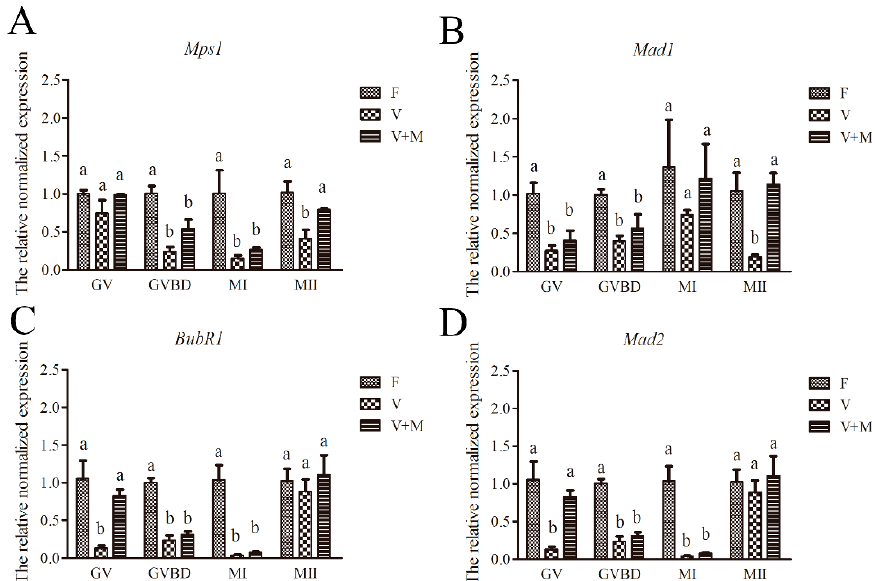
Figure 6. E ff ects of melatonin (MT) on relative mRNA expression of spindle assembly checkpoint-related (SAC) genes in vitrified-warmed GV mouse oocytes during in vitro maturation. Data are presented as mean ± SEM. The experiment was replicated at least three times. In total, n = 924 GV oocytes were used for mRNA expression analysis (F: n = 302; V: n = 323; V + M: n = 299). Di ff erent superscripts ( A – D ) indicate significant di ff erence ( p < 0.05) between groups at the same time point (corresponding developmental stages). F: fresh control oocytes without MT. V: vitrified MII oocytes without MT. V + M: vitrified MII oocytes treated with 10 − 7 mol / L MT. Di ff erent superscripts (a and b) indicate significant di ff erence ( p < 0.05) between groups at the same time point (at corresponding developmental